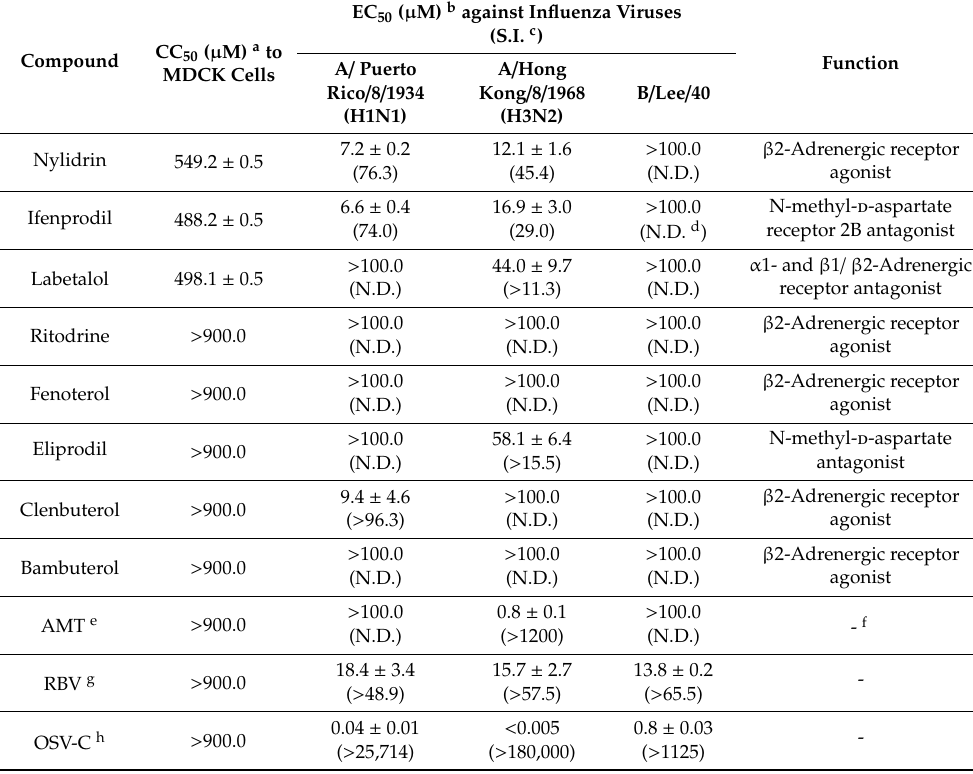
Table 1. Antiviral activity of nylidrin and its analogues against influenza viruses, PR8, HK, and Lee.